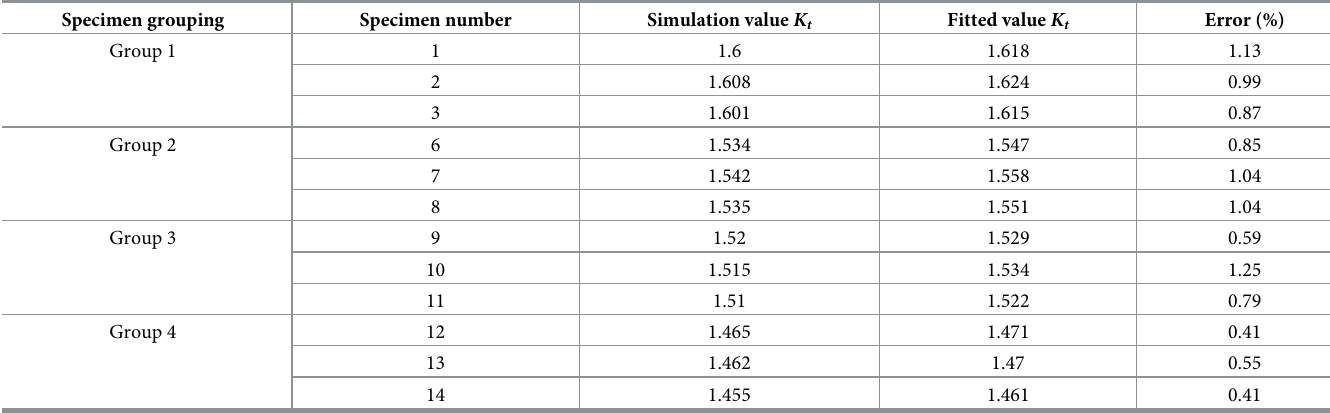
Table 5. Empirical formula fitting error for K t . Specimen grouping